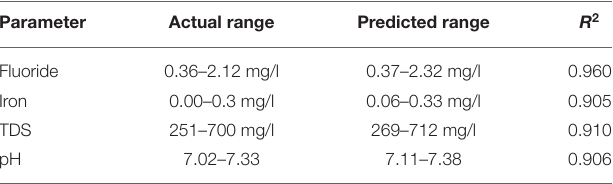
TABLE 2 | Relationship between observed vis-à-vis predicted groundwater